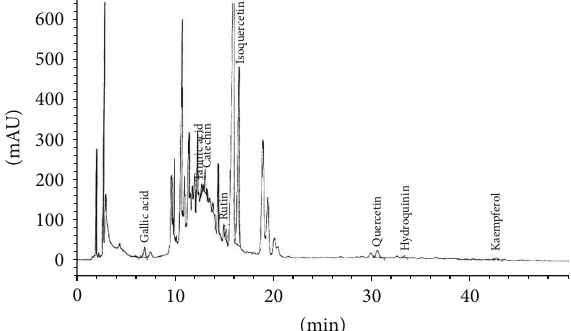
Figure 8: Cladophora glomerata extract qualification using HPLC- DAD/MSD analysis. CGE was analyzed against their phenolic standards. Semiquantitative data was analyzed by peak area under the curve relative to the content of each component in the